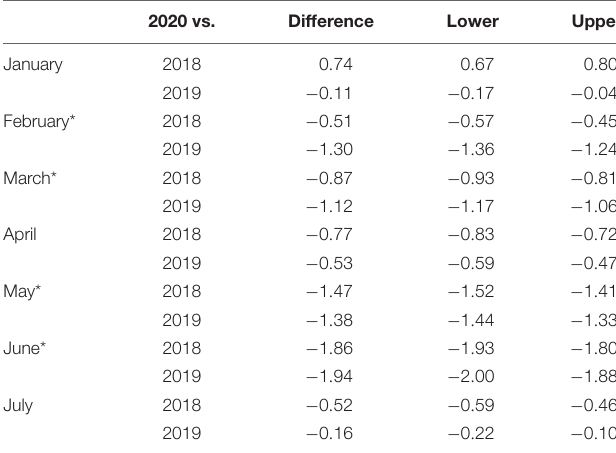
TABLE 1 | Results from Tukey Honest Significant Differences (HSD) multiple comparison applied to ANOVA models fit to data from each month